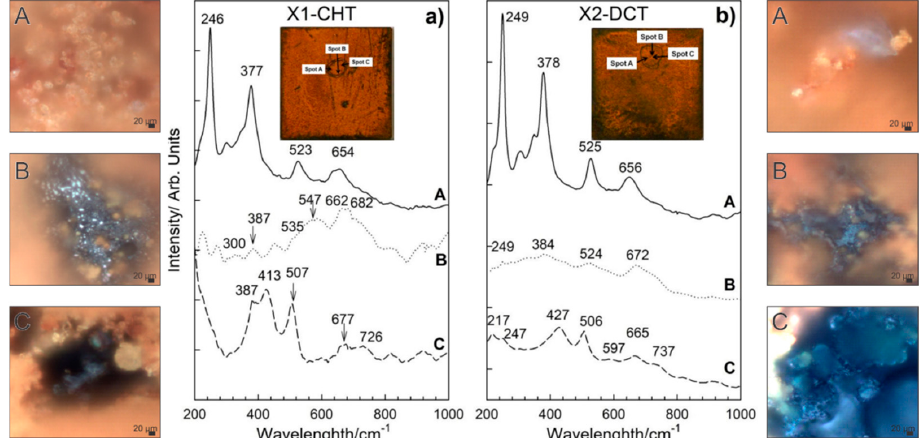
Figure 6. Raman spectra of corrosion products formed on steel samples X1-CHT ( a ) and X2-DCT ( b ) after 1 day exposure to seawater. Both spectra are also accompanied by light microscopy images ( A – C ) of corrosion products obtained at 1000× magnification.